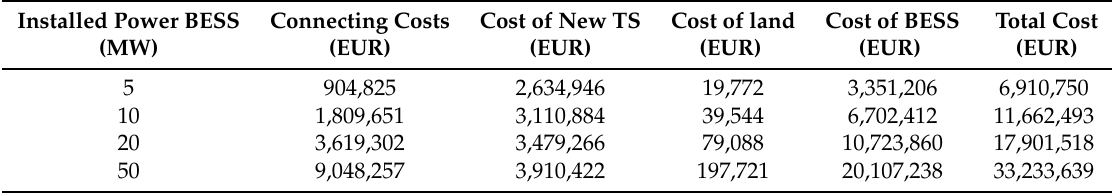
Table 2. Costs of BESS installation ( I ) at location